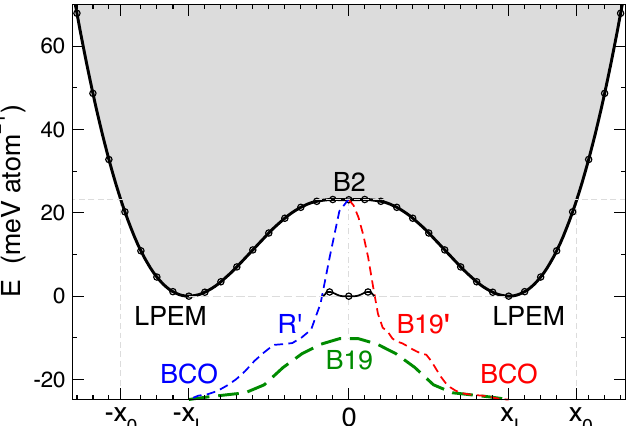
Figure 5. (color online). NiTi potential energy vs. collective atomic displacement (which changes linearly from x = 0 at unstable B2 (CsCl) to ± x L at a LPEM) for a MEP from B2 to a representative austenitic structure (LPEM, E = 0), from B2 to BCO (base-centered orthorhombic B33) ground state. The B2-to-BCO (B33) transition occurs via B19 (cid:48) or R (cid:48) structures (thin dashed lines), see Figure 6 (or also Figure 4 in [8]). Additionally, there is a pathway for a (lower-barrier) transformation between two orientations of B19’ (deformed BCO B33) martensite via B19 (thick green dashed line), see Figure 6f,g or also Figure 1b,e,f,i in [8] and Figure 3 in [8] or Figure 3 in [5]. There are low-enthalpy barriers around each austenitic LPEM (thin solid black line near x = 0, E = 0), see also Figure 4 in